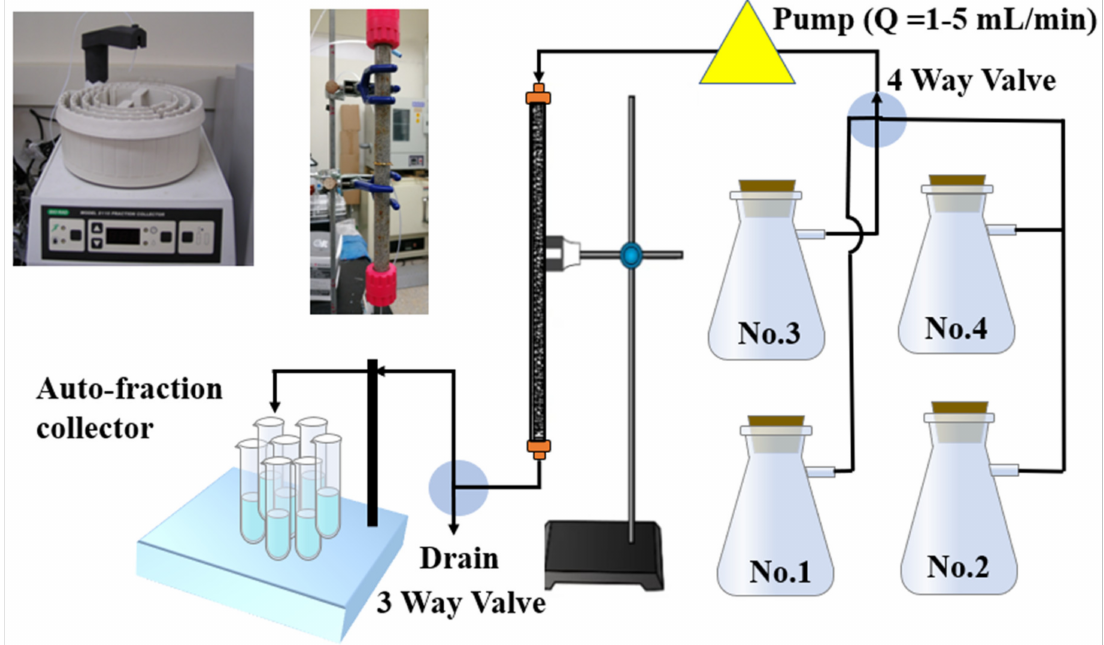
Figure 1. ADE experimental device in this work (schematic